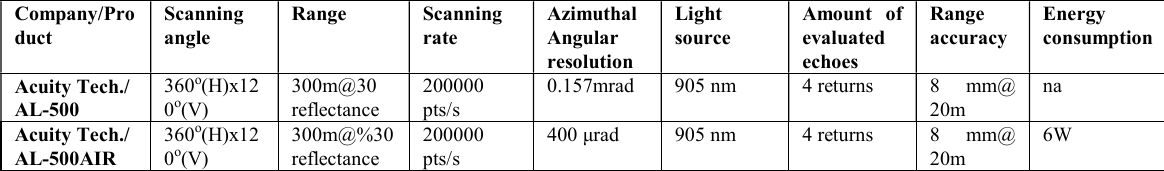
Table 5. The specifications of rotating 2D LiDAR